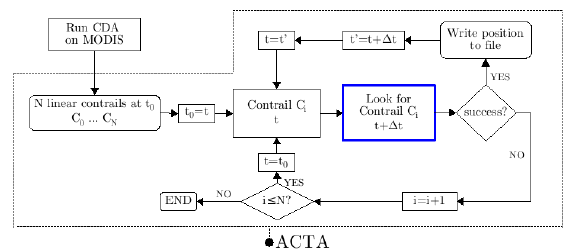
Fig. 02. Schematic representation of ACTA. Input: list of linear Fig. 2. Schematic representation of ACTA. Input: list of linear con- contrails detected by the CDA on MODIS. trails detected by the CDA on MODIS.